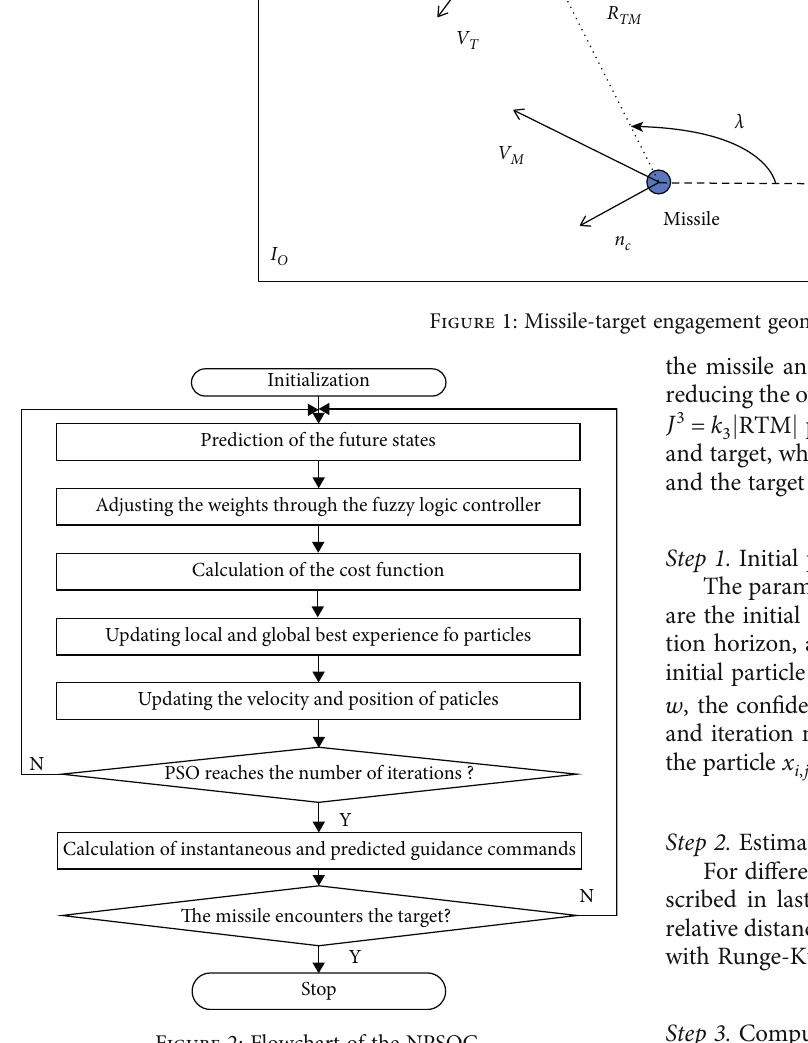
Figure 2: Flowchart of the